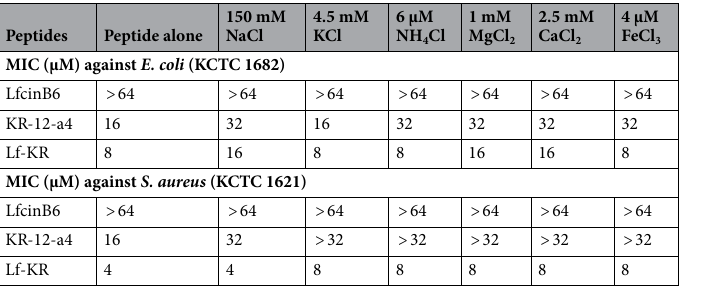
Table 3. Minimum inhibitory concentration (MIC) values of LfcinB6, KR-12-a4 and Lf-KR in the presence of physiological salts against E. coli and S. aureus.